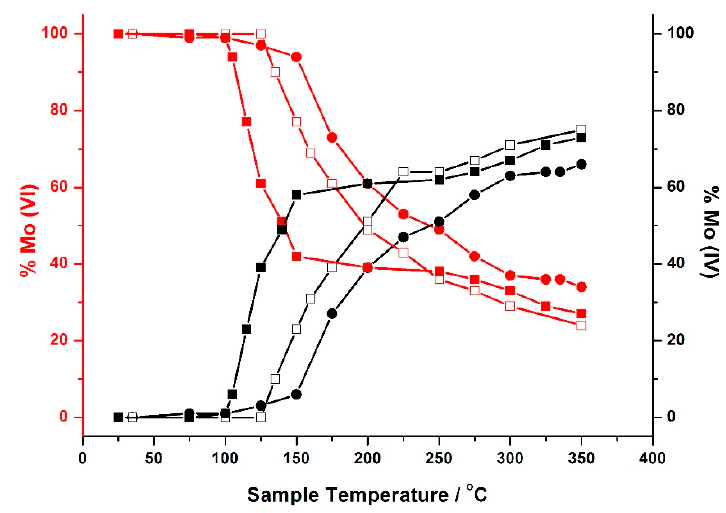
Figure 23. Oxidation state changes during in situ reduction of 1, 3 and 6ML MoO x /Fe 2 O 3 ascertained through monitoring the change in absorption edge position from Mo (VI) to Mo (IV). Reduction was carried out in a MeOH/He flow whilst heating to 350°C at a rate of 12 °C ∙ min − 1 under atmospheric pressure. XAFS spectra were collected throughout (~1 min per scan). 1ML = filled squares, 3ML = open squares, 6ML = filled circles. Figure adapted from C. Brookes et al. , Catal. Sci. Technol. , 2016, 6, 722 [35].